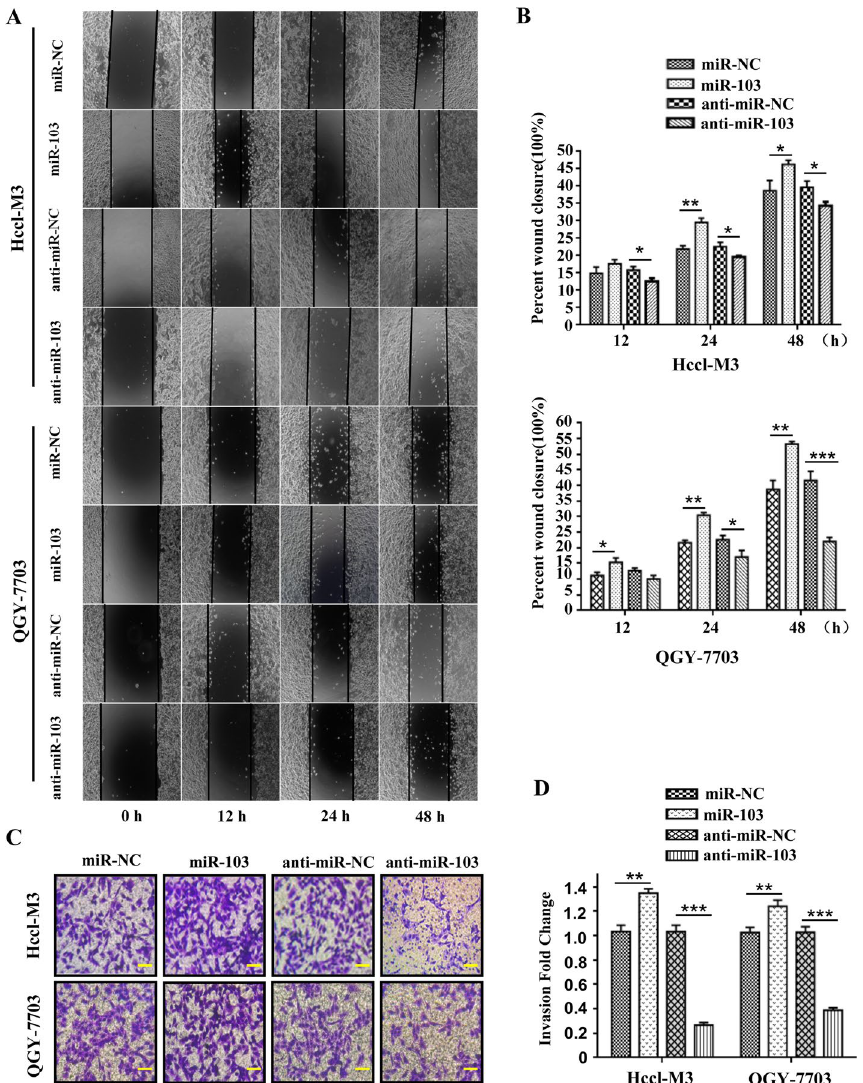
Fig. 4 miR-103a-3p promotes HCC cells migration and invasion. Hccl-M3 and QGY-7703 cells were transfected with miR-103a-3p mimics, mimics control, miR-103a-3p inhibitor or inhibitor control, 24 h later, the migratory capacity was evaluated by wound healing assay ( A , B ) and the invasive ability was detected by transwell matrigel invasion assay ( C , D ). Scale bars, 50 μm. Data are shown as means independent experiments. * P < 0.05, ** P < 0.01, *** P <